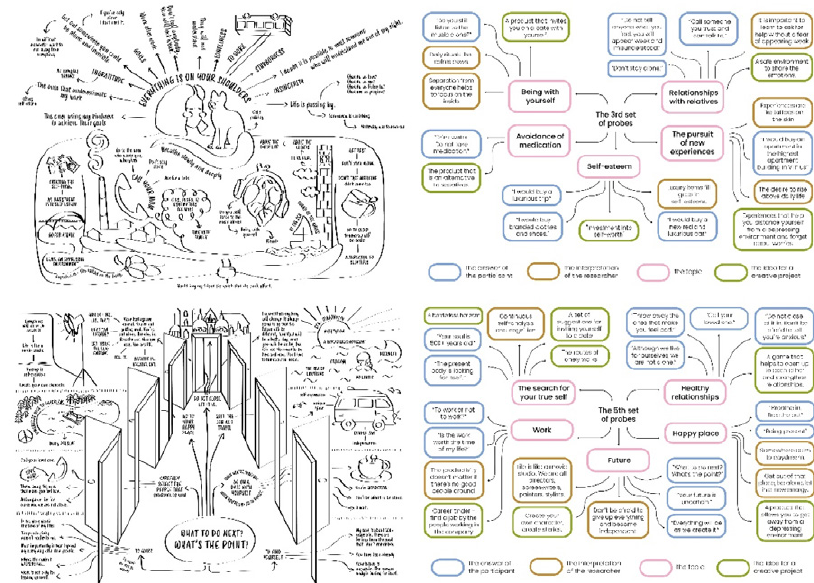
Figure 2. The visual sketches created while analysing the outcome of the cultural probes study “When Nobody Sees” (source: Liebutė,